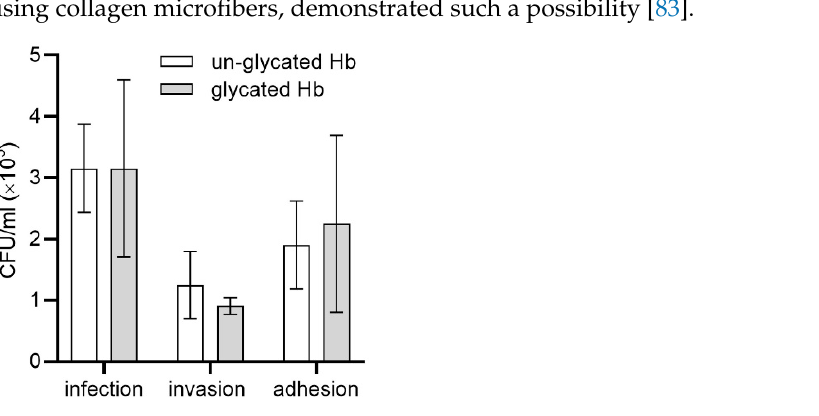
Figure 7. Infection assay. Immortalized human gingival keratinocytes were incubated with P. ginvivalis cells in the presence of glycated or un-glycated hemoglobin (Hb). The number of viable bacteria was determined as colony forming units (CFU) per mL. Adhesion, the number of live bacteria attached to the surface of keratinocytes; invasion, the number of live bacteria that invaded keratinocytes; infection, the total number of live bacteria in co-cultures of P. gingivalis -keratinocytes. The data are expressed as mean ± SD from one representative experiment showing a similar trend in three independent experiments.